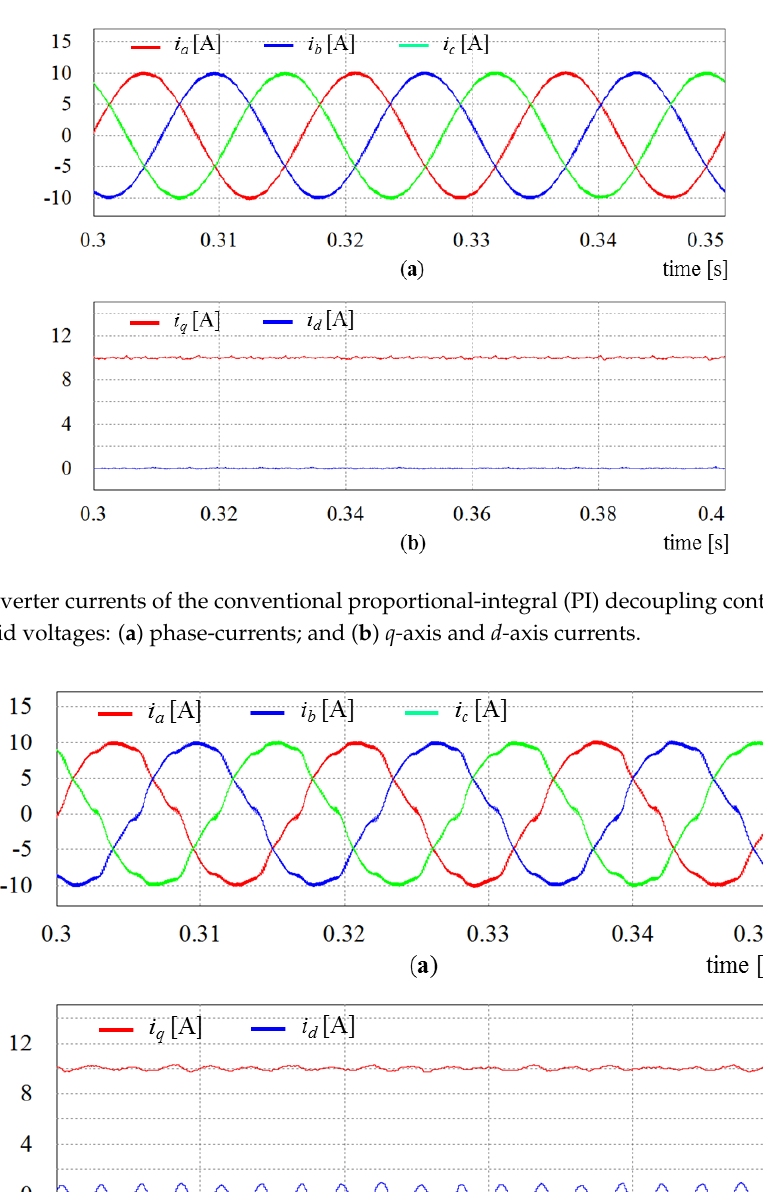
Figure 8. Dynamic response of the moving average filter phase lock loop (MAF-PLL) under the distorted grid voltages: ( a ) angular frequency; and ( b ) angular displacement.